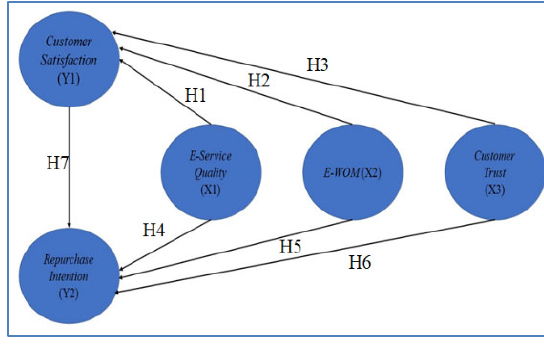
Fig. 1. Framework of the proposed